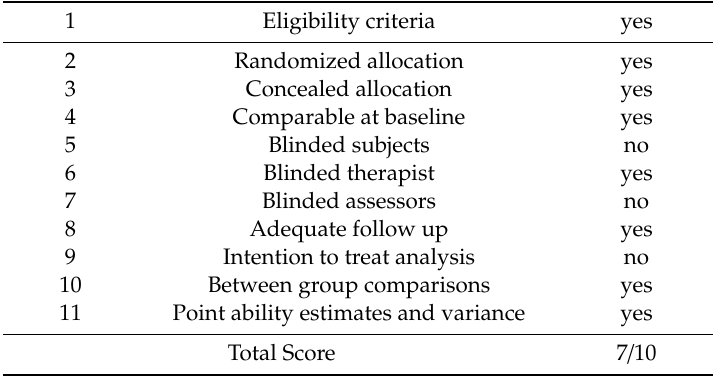
Table 1. The used PEDro scale for reporting the three randomized divided groups. 1 Eligibility criteria yes 2 Randomized allocation yes 3 Concealed allocation yes 4 Comparable at baseline yes 5 Blinded subjects no 6 Blinded therapist yes 7 Blinded assessors no 8 Adequate follow up yes 9 Intention to treat analysis no 10 Between group comparisons yes 11 Point ability estimates and variance yes Total Score 7 /